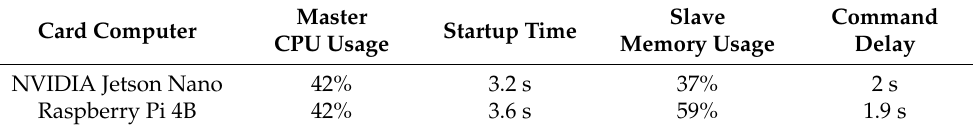
Figure 19. Two representative card type micro-computers: ( a ) NVIDIA Jetson Nano and ( b ) Raspberry Pi 4B. Table 1. Performance analysis of HIL system based on the different card type micro-computers.